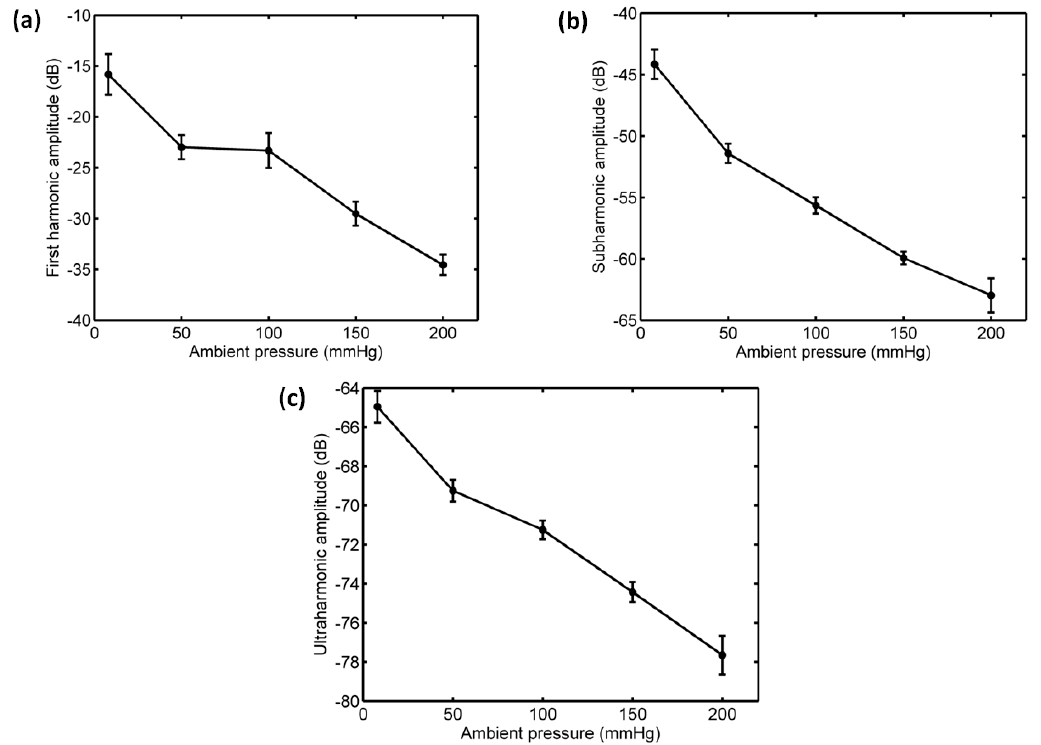
Figure 19. The relationships between the frequency components of the microbubbles’ scattered signals and the overpressure. ( a ) The first harmonic amplitude vs. ambient pressure, ( b ) the subharmonic amplitude vs. ambient pressure, and ( c ) the ultraharmonic amplitude vs. ambient pressure. The driving frequency was 1.33 MHz, the acoustic pressure was 350 kPa. The transmitted tone burst with 64 cycles had a PRF of 1 kHz.